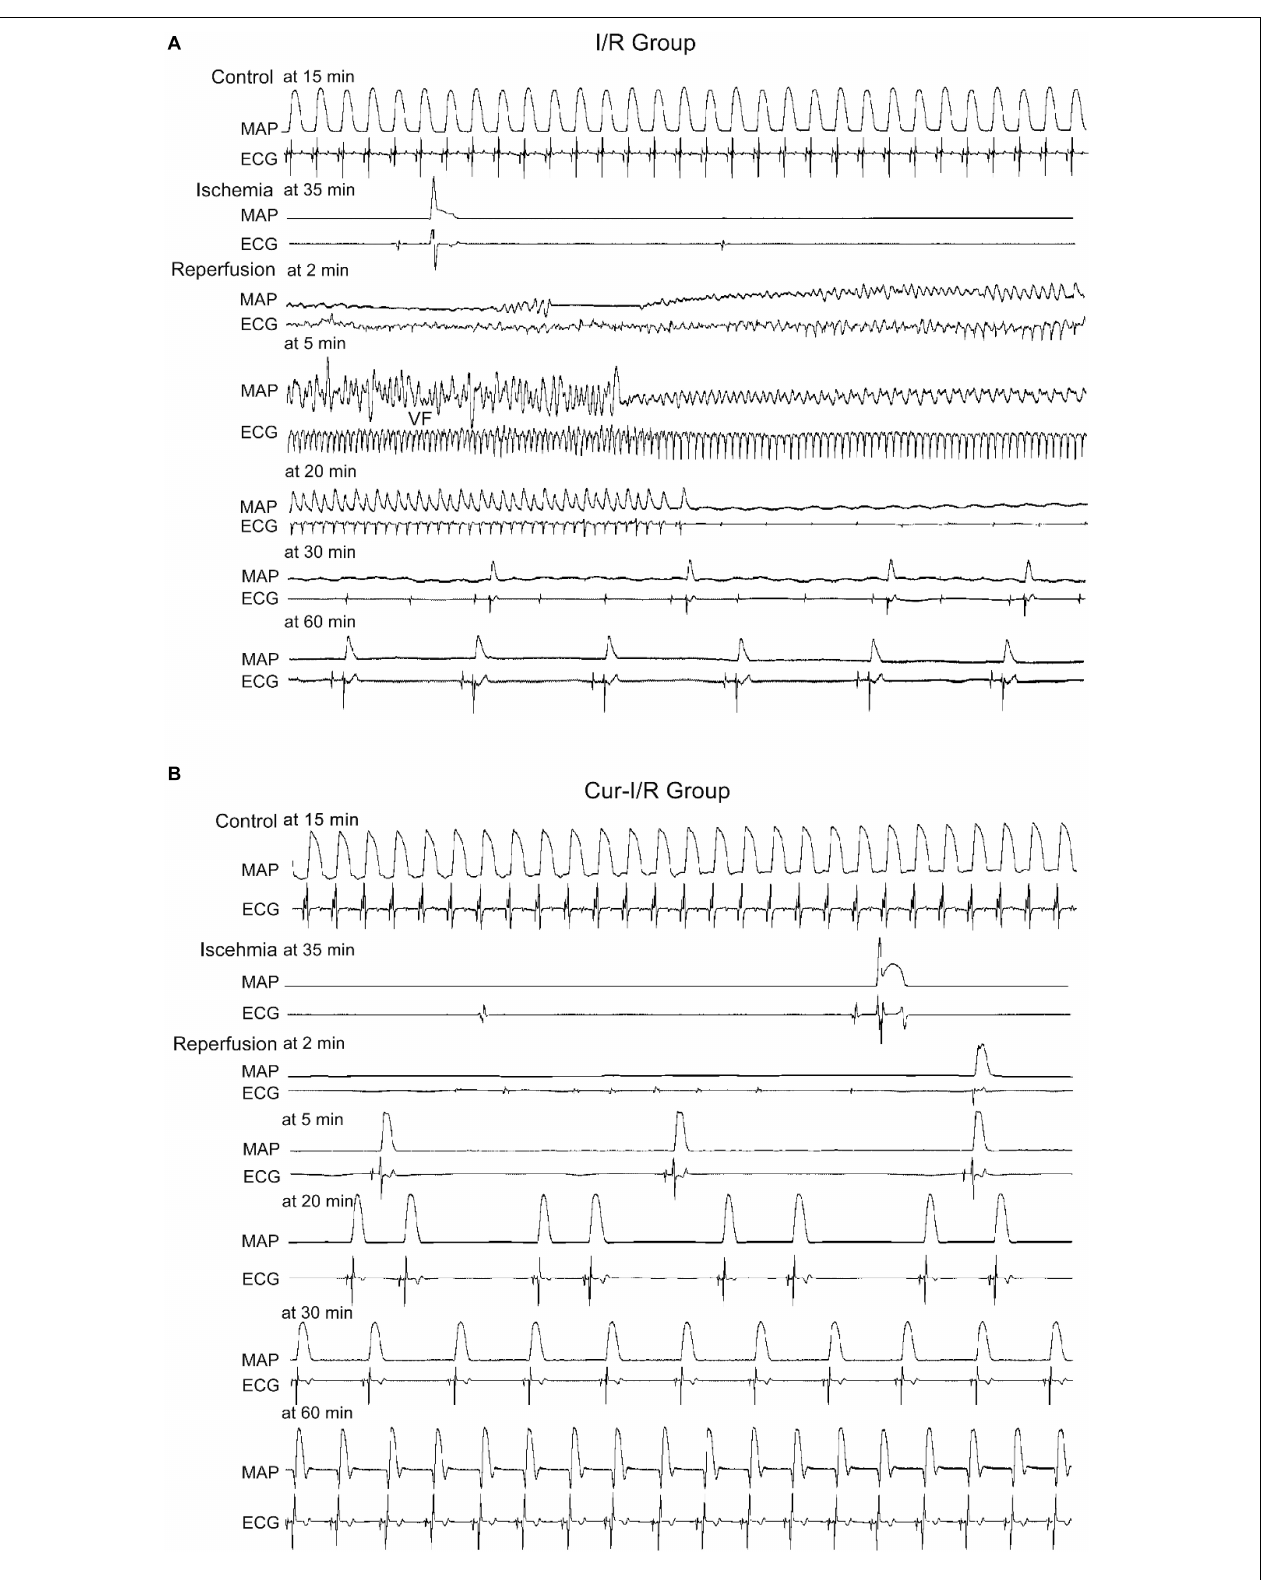
FIGURE 7 | The effects of Cur on isolated rabbit hearts that suffered from ischemia–reperfusion (I/R). (A,B) Example records of MAP and ECG of the Langendorff-perfused hearts in the I/R group (A) and Cur-I/R group (B) .